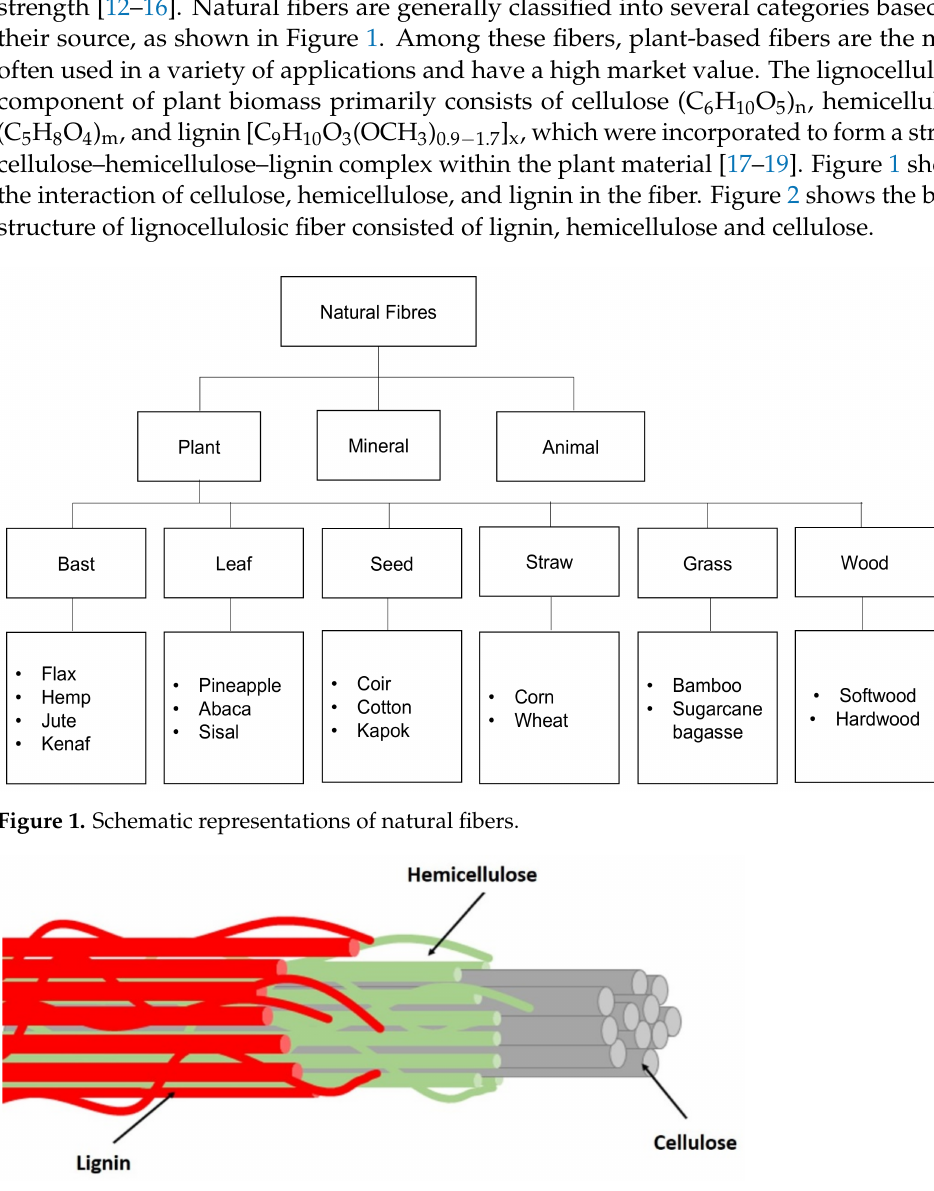
Figure 2. Basic structure of lignocellulosic